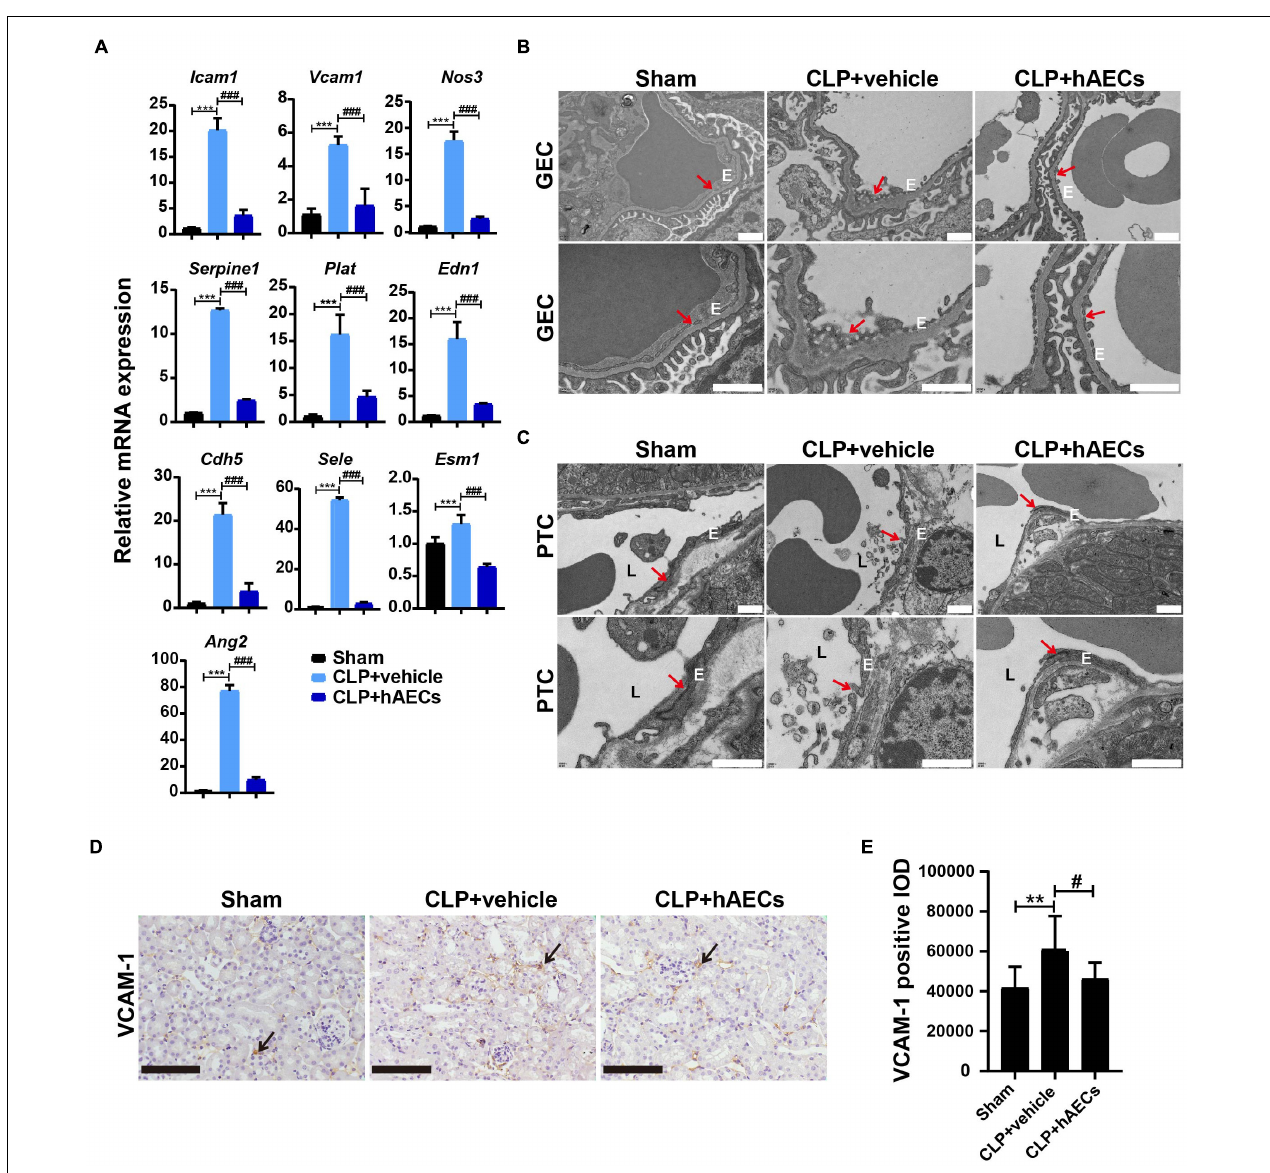
FIGURE 4 | hAECs protected the endothelial cell structure and function from sepsis-associated inflammatory injury. (A) The mRNA levels of indicators associated with endothelial cell adhesion and function of septic mice kidney at 16 h after CLP ( n = 3). *** P < 0.001 vs. the sham group; ### P < 0.001 vs. the CLP + vehicle group. (B) Electron microscope images shown glomerular endothelial cell (GEC) fenestrae in the CLP mice at 16 h after CLP. The arrows indicate fenestrae of GECs. Scale bar = 1 µ m. E: endothelial cell. (C) Electron microscope images shown tight junction disruption and the damage of the peritubular capillary endothelial layer in the CLP mice at 16 h after CLP. The arrows indicate tight junctions between two adjacent endothelial cells of the peritubular capillary (PTC). Scale bar = 1 µ m. E: endothelial cell. L: peritubular capillary lumen. (D) Immunohistochemistry staining of vascular cell adhesion molecule-1 (VCAM-1) in kidney paraffin sections from the indicated groups at 16 h after CLP. Scale bar = 50 µ m. Arrows indicate the positive staining. (E) Statistical comparison of integrated optical density (IOD) of VCAM-1 positive staining in the indicated groups. ** P < 0.01 vs. the sham group; # P < 0.05 vs. the CLP + vehicle